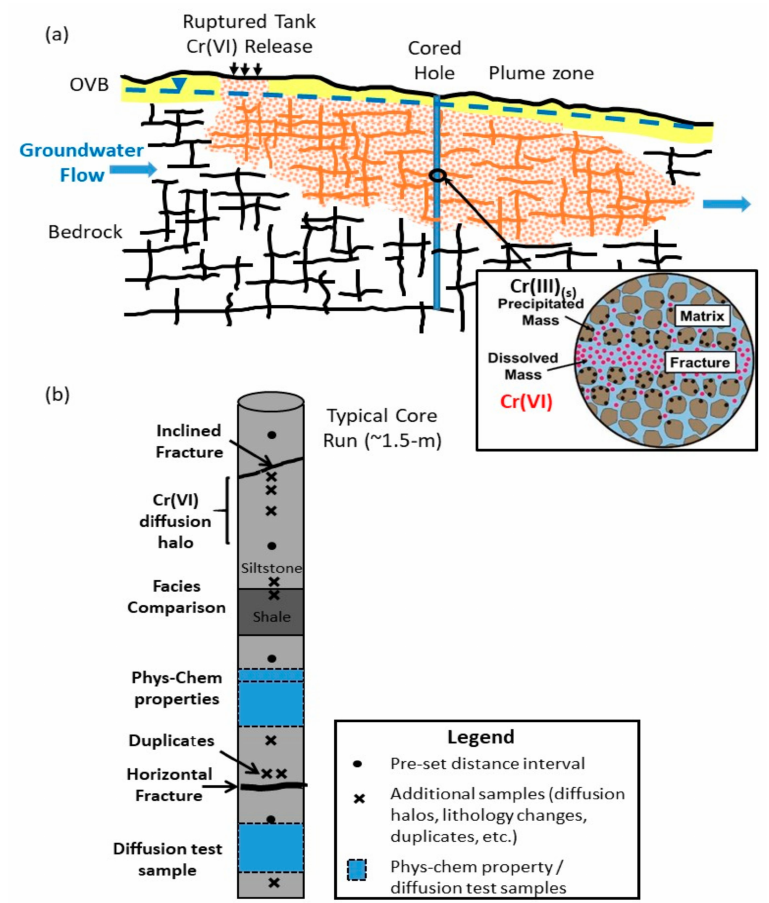
Figure 1. ( a ) Conceptual model for Cr ( VI ) plume development and attenuation in fractured bedrock due to matrix diffusion and reaction processes with a cored hole for high resolution investigation; and ( b ) conceptual approach for high resolution core sampling (adapted from Parker et al.